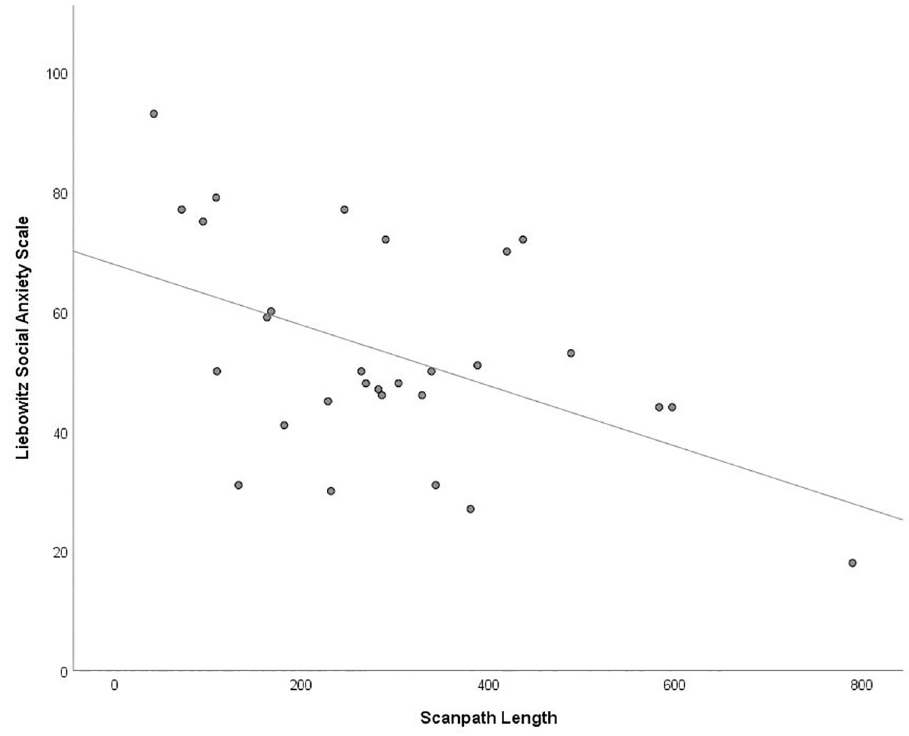
Fig 3. Scatterplot showing the significant negative correlation between scanpath length in degree of visual angle and score on the Liebowitz Social Anxiety Scale. https://doi.org/10.1371/journal.pone.0259007.g003 count ( F (2, 58) = 289.70, η p2 = .909, p < .001) with participants allocating more dwell time and fixations to the background than the body with the fewest allocated to the head (all pair- wise comparisons p < .001) (Table 1 for means).